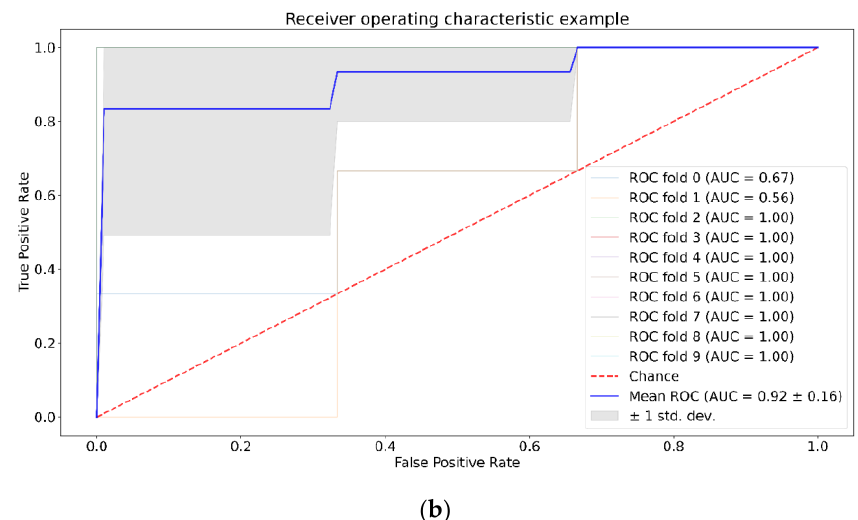
Figure 6. ROC AUC analysis for RF, third week, no PCA ( a ) and with PCA ( b ).